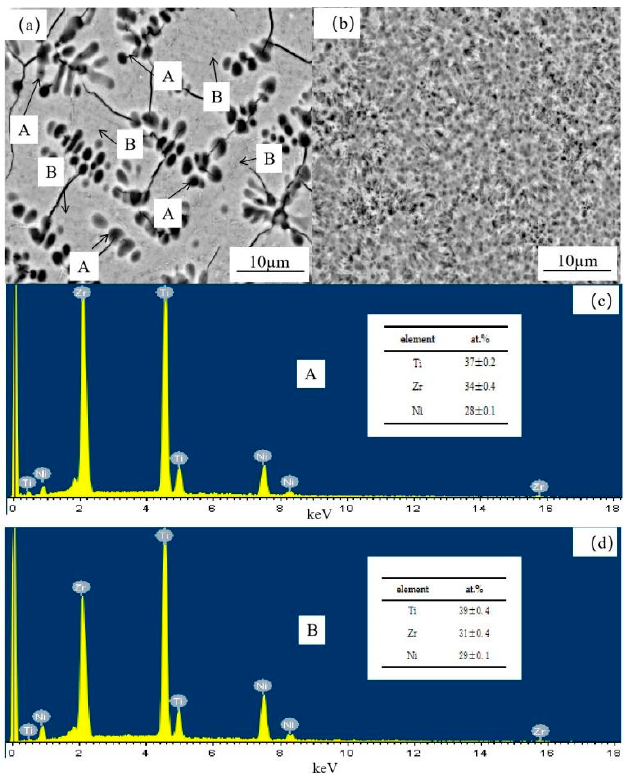
Figure 2. SEM morphology of: ( a ) The Ti 40 Zr 40 Ni 20 rod; ( b ) The Ti 40 Zr 40 Ni 20 ribbon. The EDS spectrum of the Ti 40 Zr 40 Ni 20 rod: ( c ) The α -solid solution phase (A); ( d ) The I-phase (B).